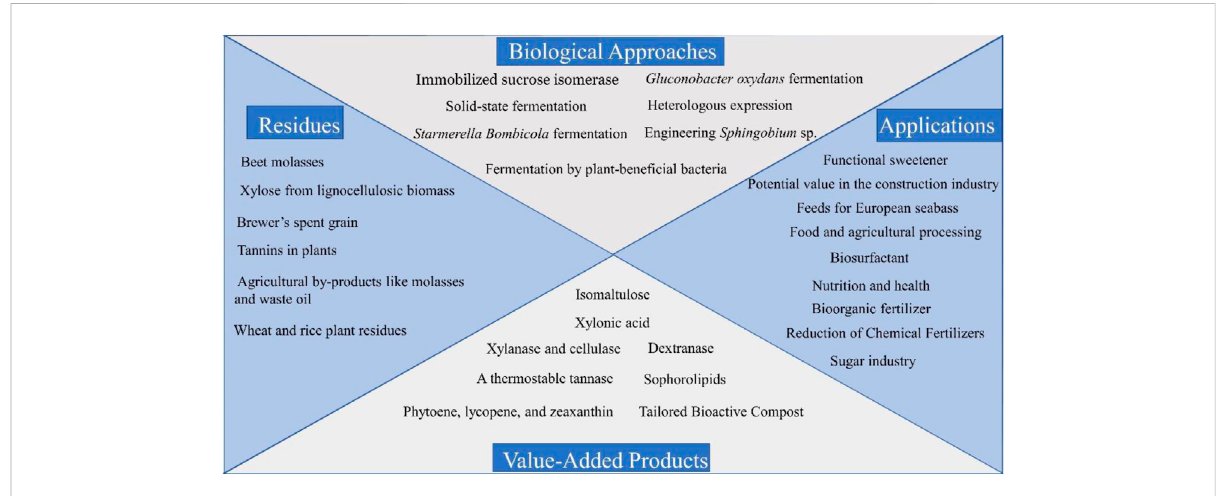
FIGURE 1 A general categorization of the keywords of the ten research